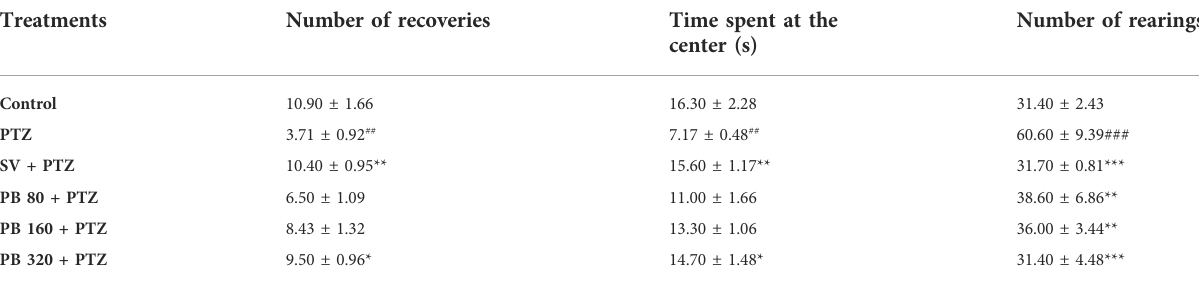
TABLE 1 The aqueous extract of P. biglobosa reduced anxiety-like behavior in the open fi eld test. Treatments Number of recoveries Time spent at the